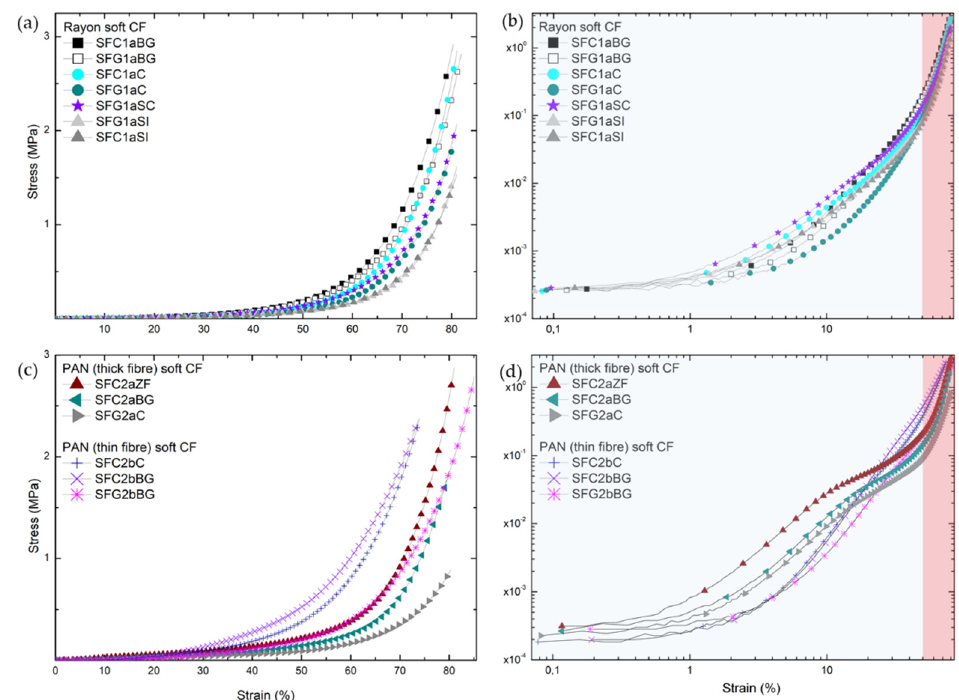
Figure 2. Stress-strain characteristics of soft carbon felts (CFs), subjected to uniaxial compression along their out-of plane (OP) (z) direction, derived from: ( a ) Rayon-derived and ( c ) polyacrylonitrile (PAN)-derived (thin and thick fibers); Logarithmic representations of ( a ) and ( c ) are given in ( b ) and ( d ), respectively, with indication of the compression zones influenced by different deformation regimes (“non-linear elastic”—transparent blue and “solid”—transparent red zone).